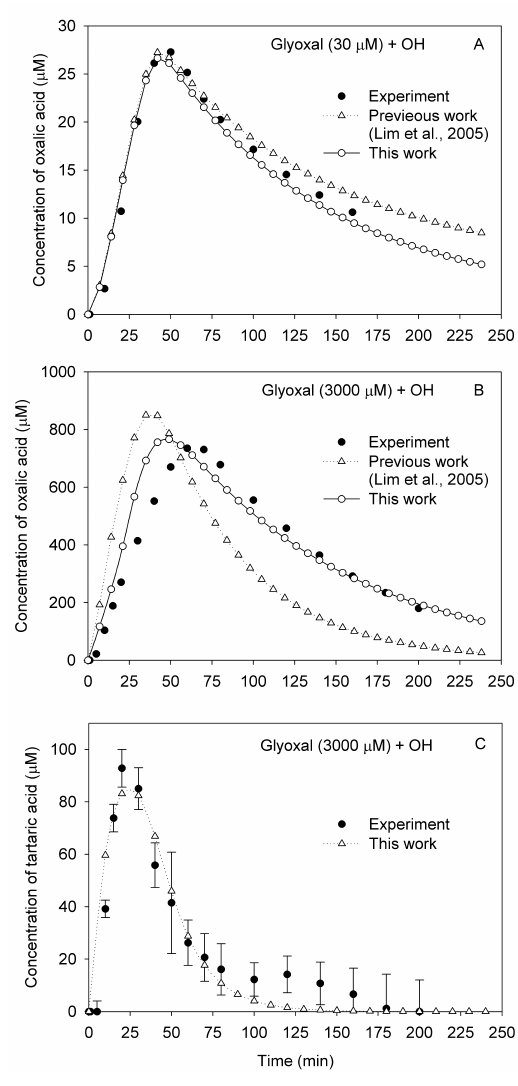
Fig. 8. IC measurements of oxalic acid formed from OH-radical reactions of glyoxal at 30µM (A) and 3000µM (B) , and model sim- ulations from the previous work (Lim et al., 2005) and this work. (C) IC measurements (tartaric acid + malonic acid) and the model simulation for tartaric